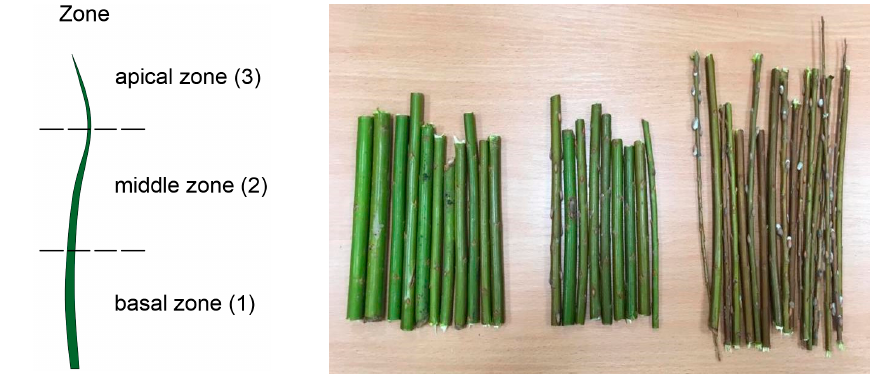
Figure 3. The zones of biomass material.